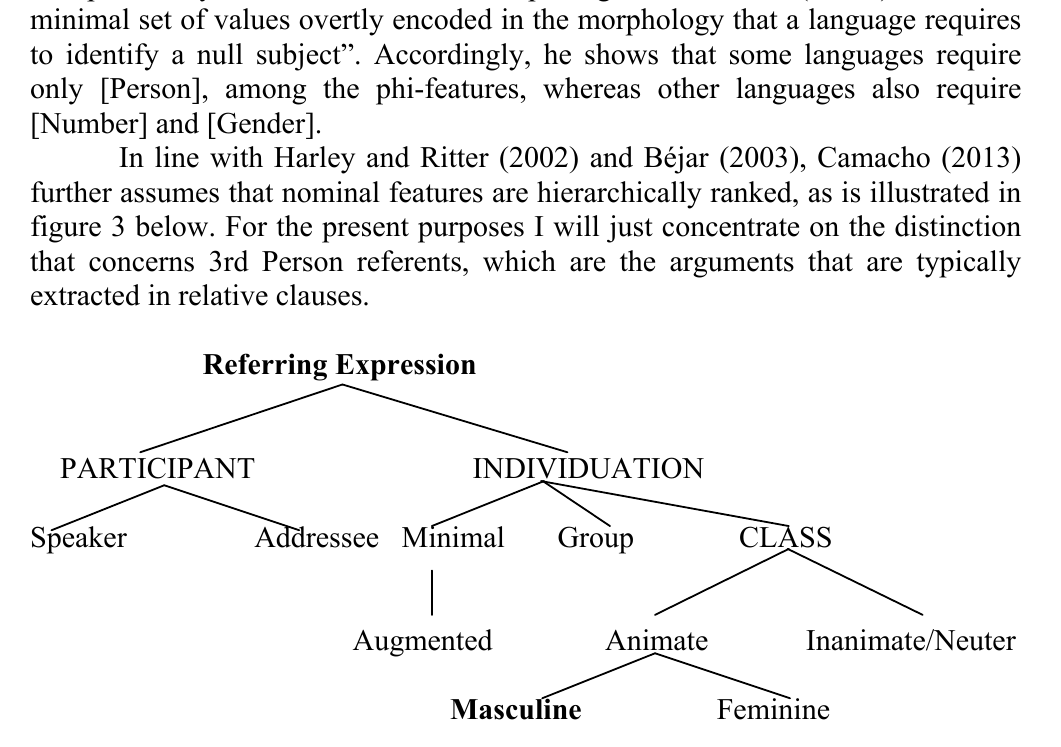
Figure 3 . Hierarchical ranking of nominal features, from Harley & Ritter